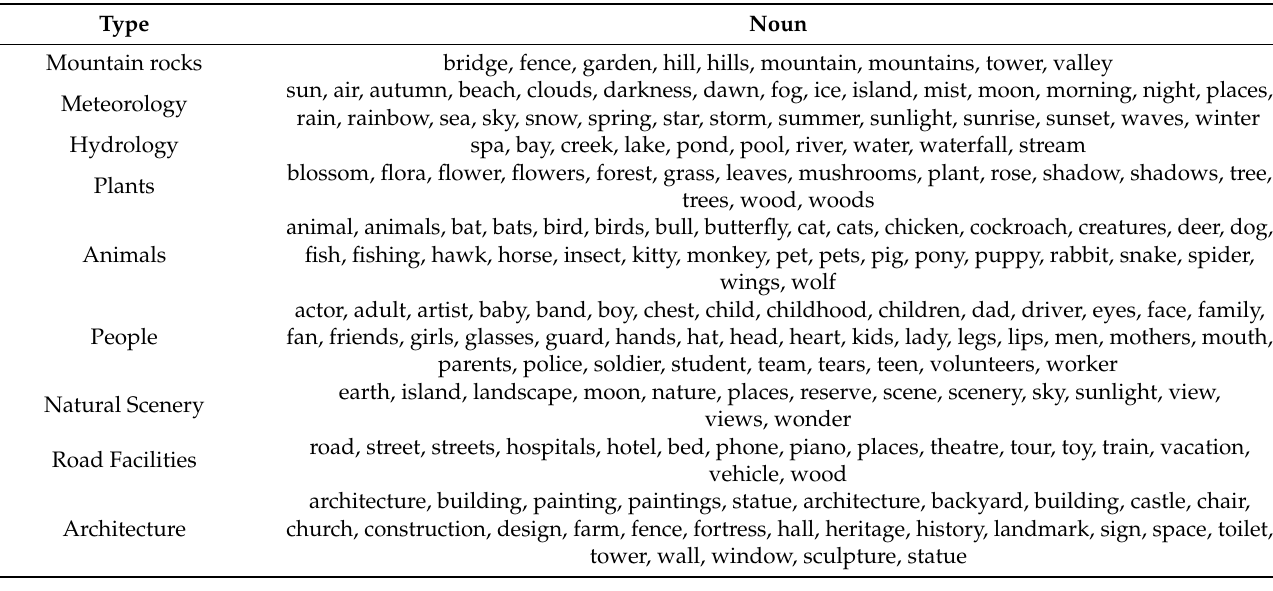
Table 1. Huangshan tourists’ photos focus